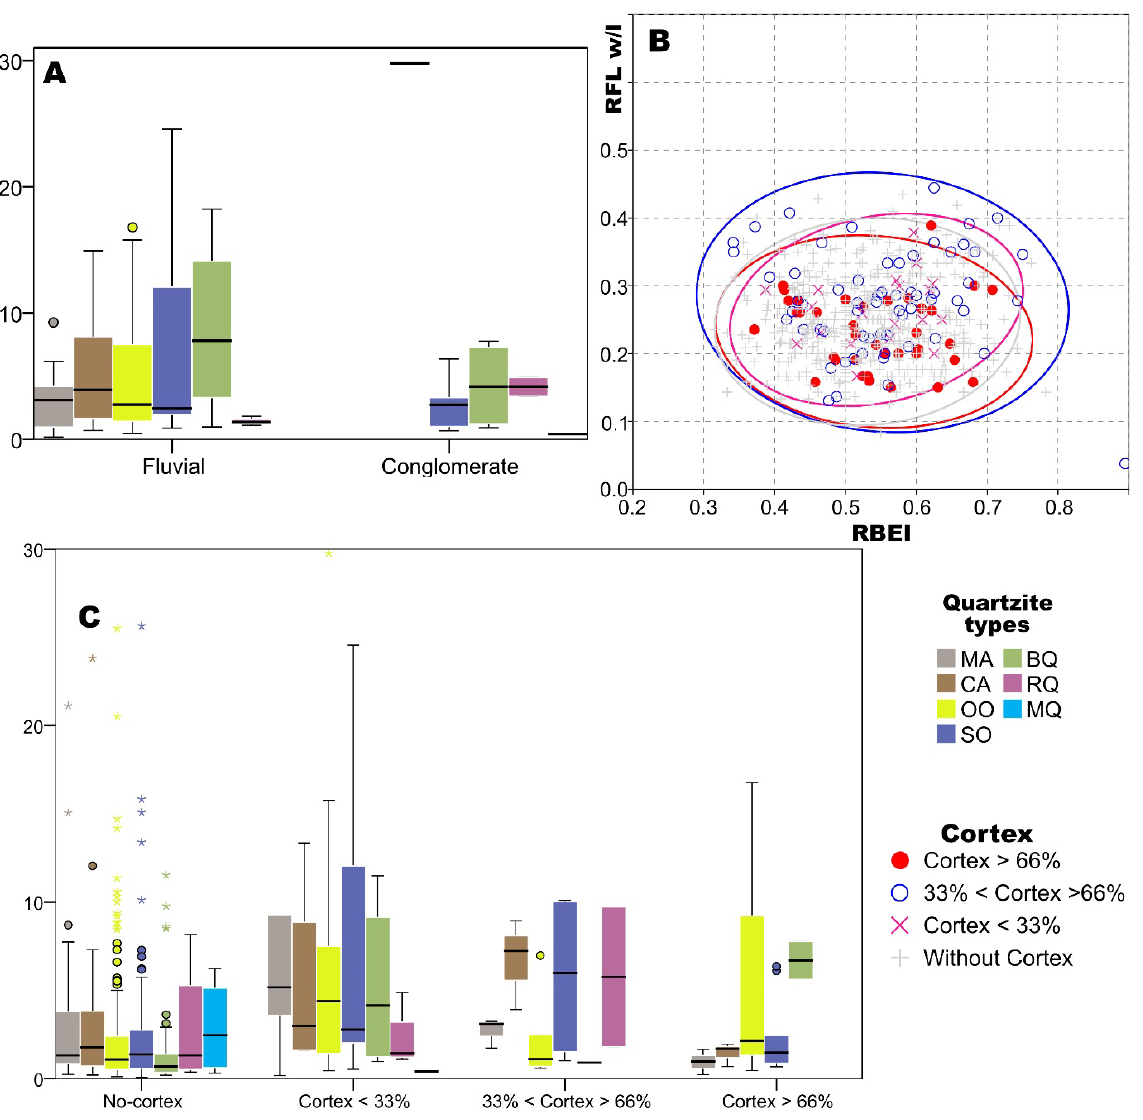
Figure 8. A) Boxplot with the distribution of weight in grams of quartzite with cortical areas grouped by cortex type and by quartzite types. B) Scatter plot of RFLw or RFLl, (Flatness Index) and RBEI (Elongation index) for blanks according to the quantity of cortex on them. Ellipses represent 95% of cases. C) Boxplot showing the distribution of weight in grams of quartzites grouped by cortex preservation and by quartzite